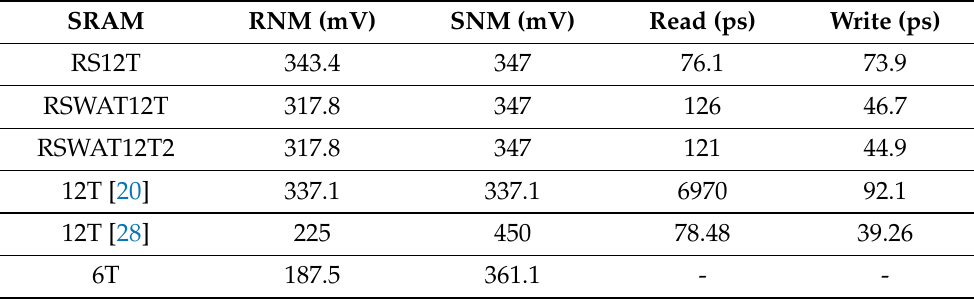
Table 4. Comparison of effective cost in terms of stability and